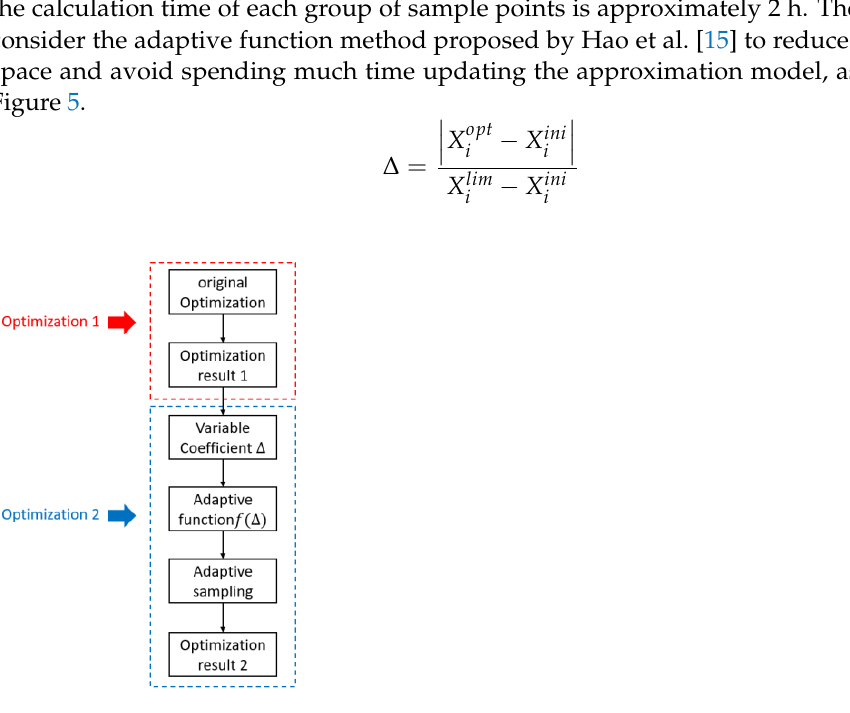
Figure 5. Schematic diagram of the adaptive sampling process. In the formula, X opt represents the first-step optimization value of the i -th variable, i X ini represents the initial value of the i -th variable, and X lim i limits of the i -th